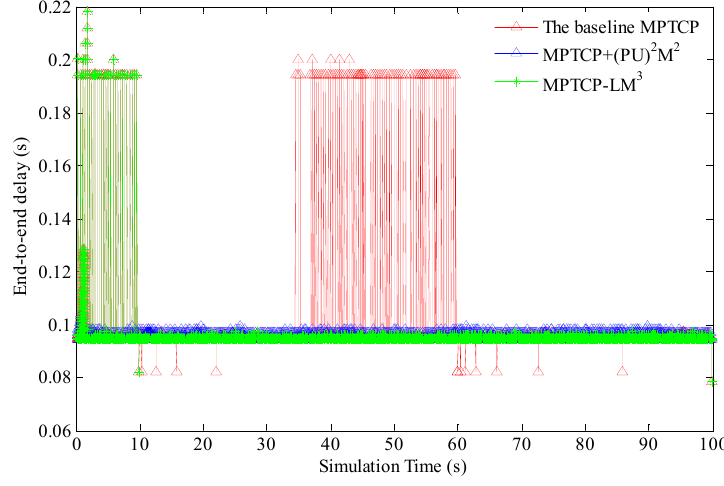
Figure 10. The comparison of end-to-end